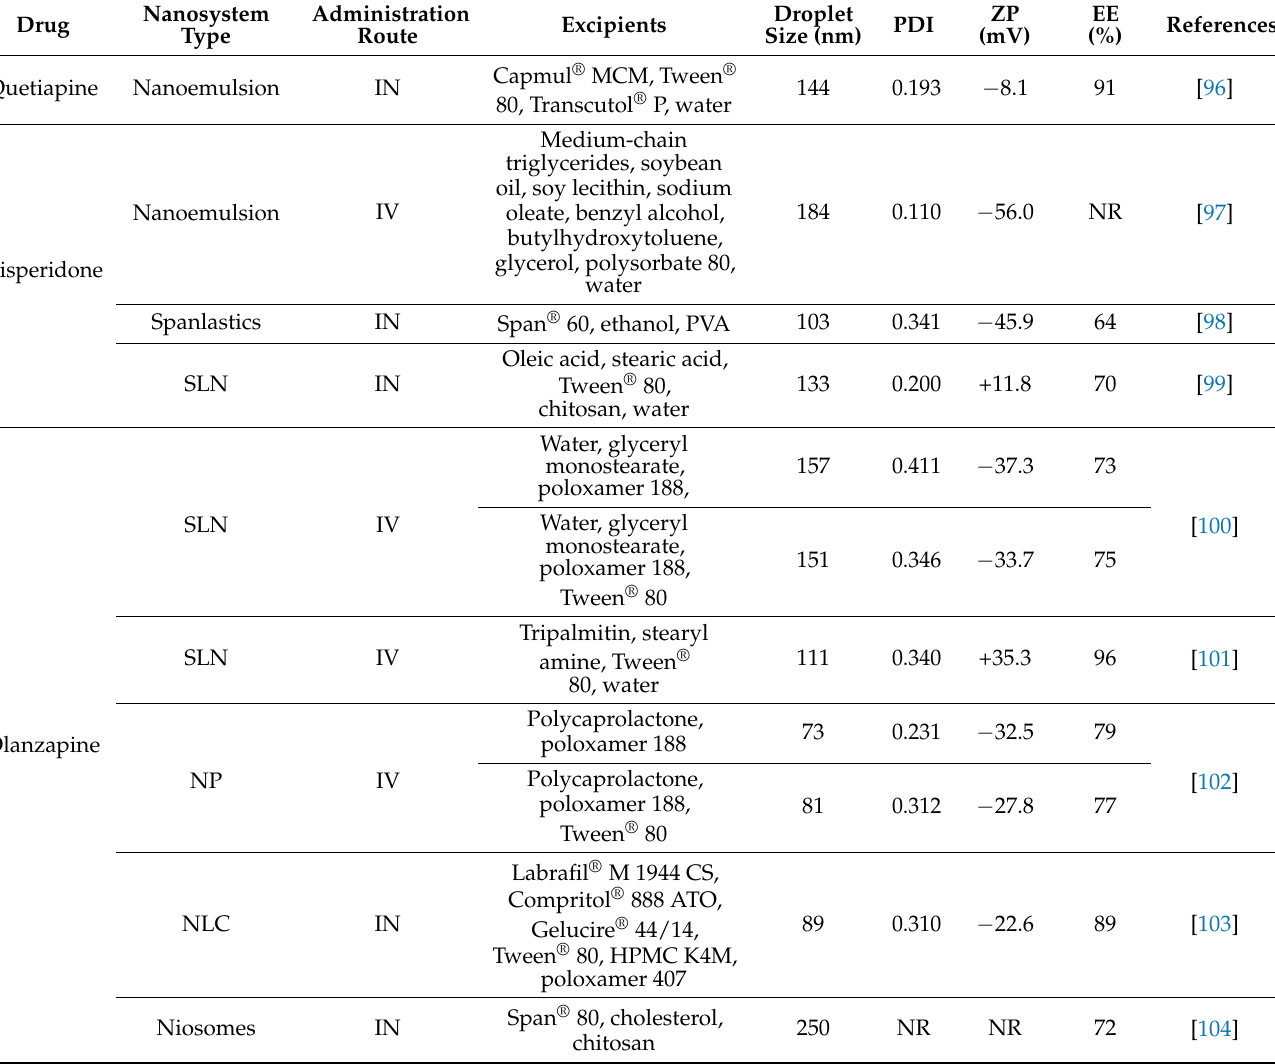
Table 2. Summary of the included nanosystems’ type, composition, and characterization